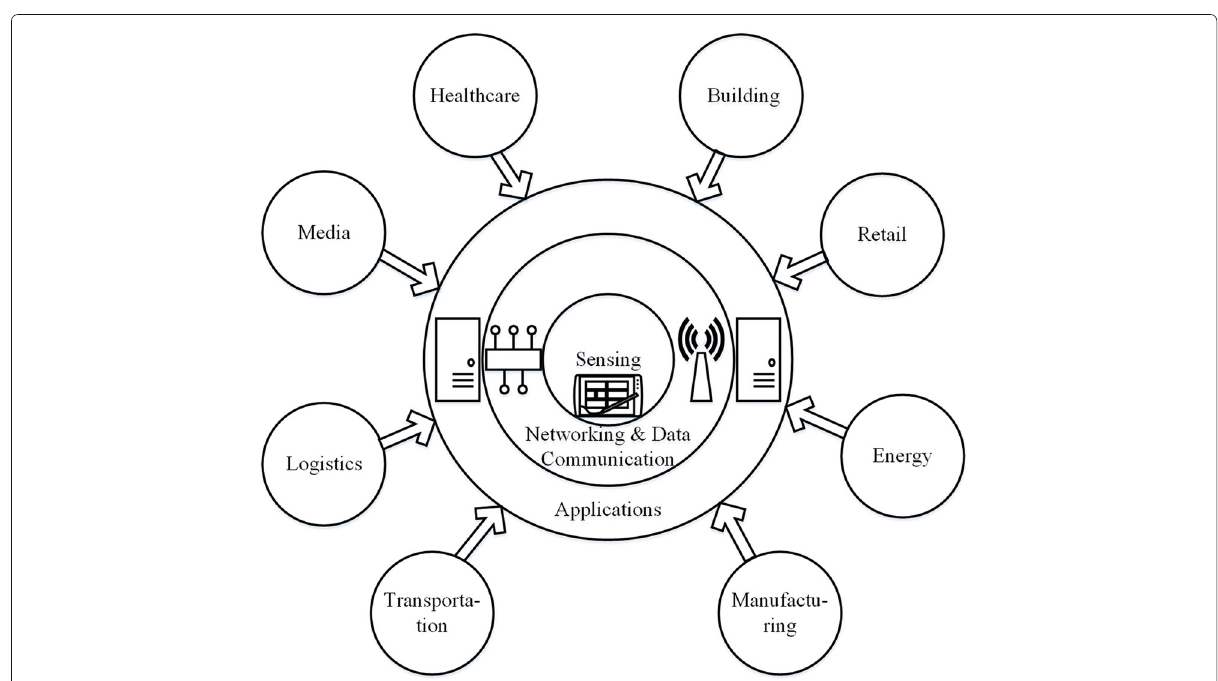
Fig. 3 IoT-based smart environments. The architecture of the IoT and the extent of the IoT market according to